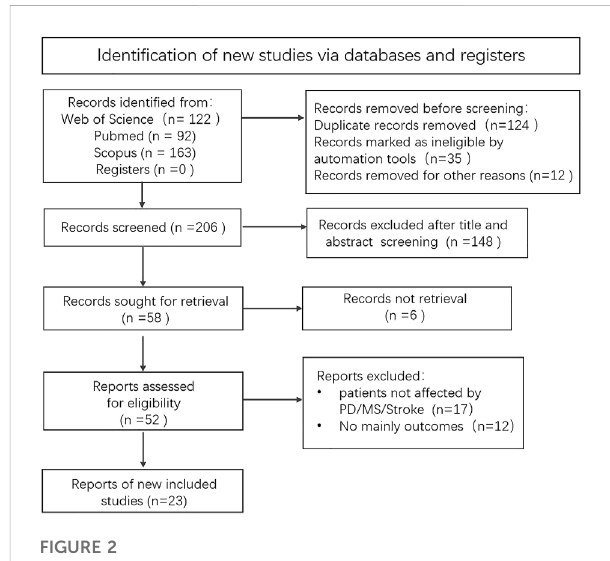
FIGURE 2 Search and screening